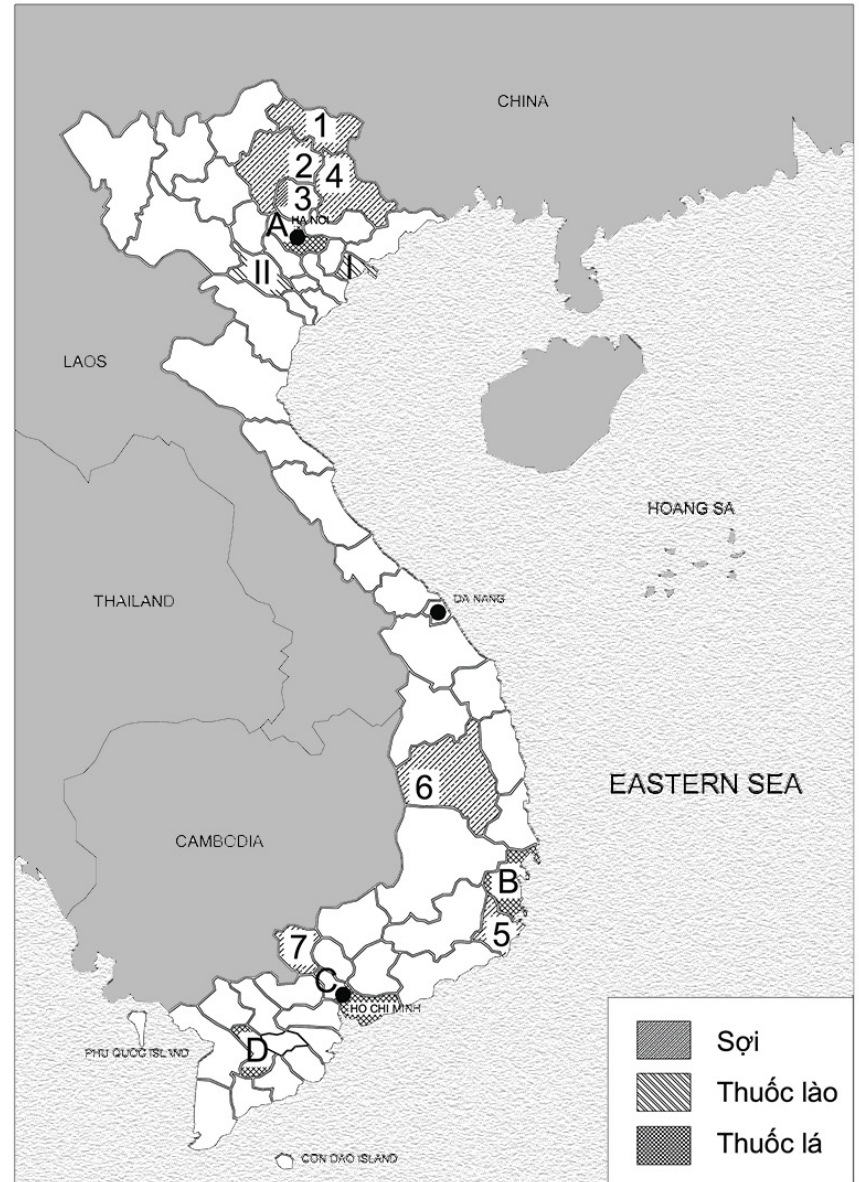
Figure 1. Locality of the origin of the collected Vietnamese tobacco